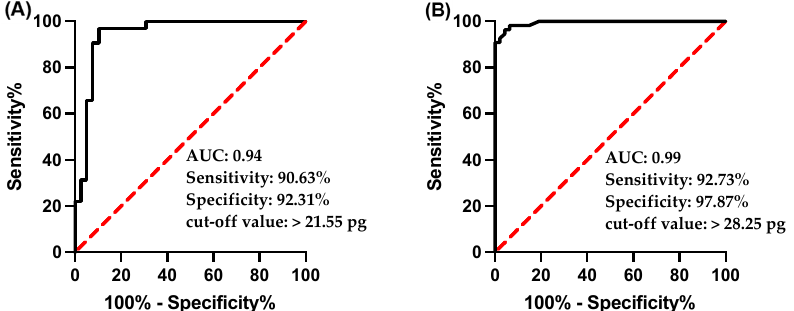
Figure 4. Receiver-operating characteristic (ROC) analysis of reticulocyte hemoglobin equivalent (RET-He) in the diagnosis of ( A ) IDA, and ( B ) ID.